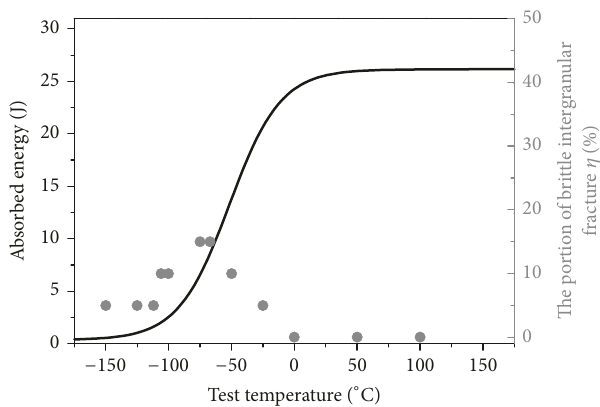
Figure 2: Typical dependence of portion of brittle intergranular fracture and absorbed energy on impact test temperature